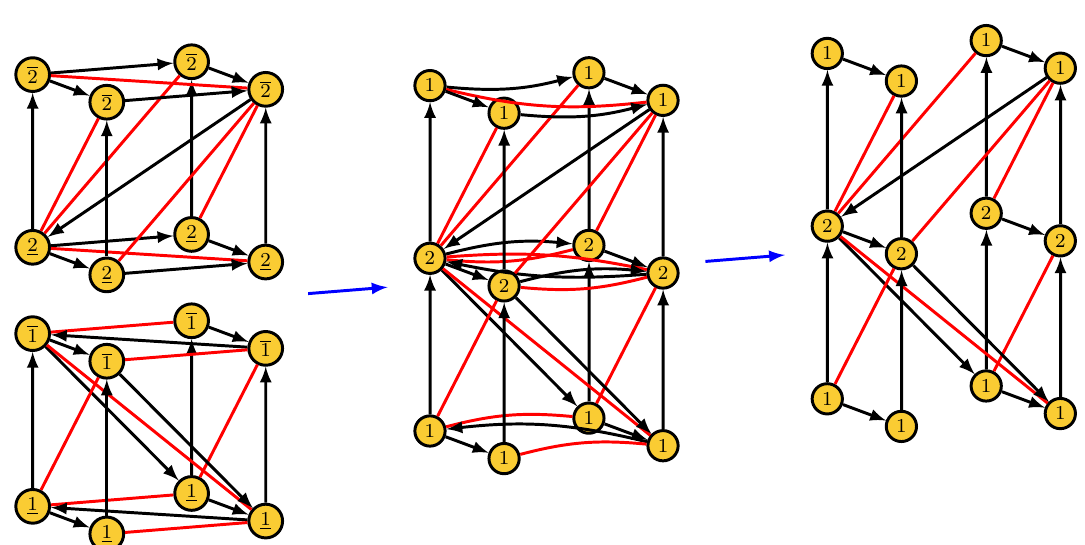
Figure 9. 3 d printing of the periodic quiver for the conifold corresponding to di(cid:11)erent perfect matchings. Four massive chiral-Fermi pairs are integrated out in the last step.